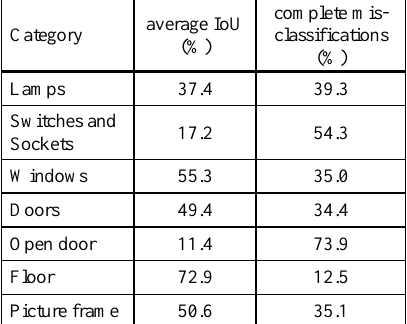
Table 5. Average IoU of each class, compared with the percentage of complete mis-classifications of each class. A high percentage of complete mis-classifications at the same time means a worse average IoU for the class.